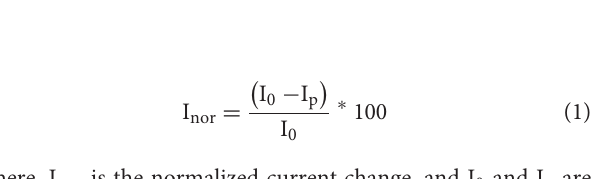
FIGURE 2 | FTIR spectra of NAA membrane at various surface modification steps, after hydroxylation (A) , silanization (B) , and antibody immobilization (C)